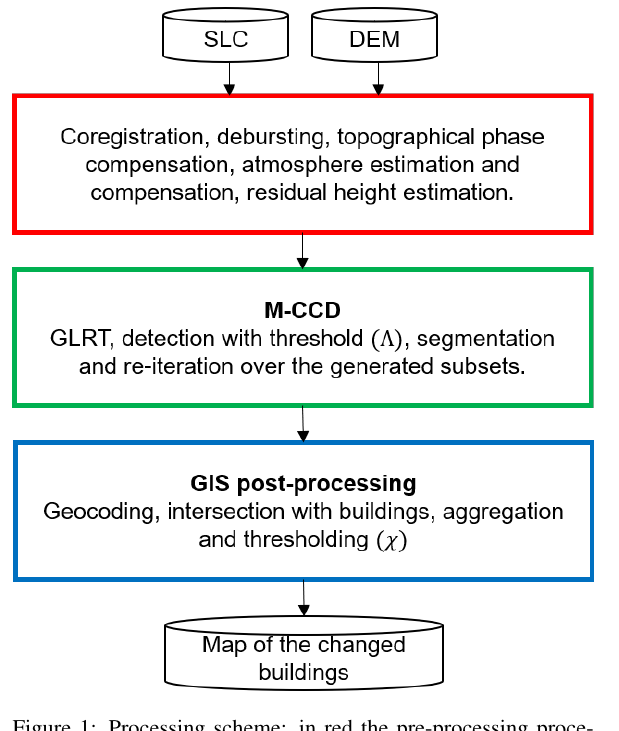
Figure 1: Processing scheme: in red the pre-processing proce- dure, in green the proposed M-CCD and in blue the GIS-based post-processing.